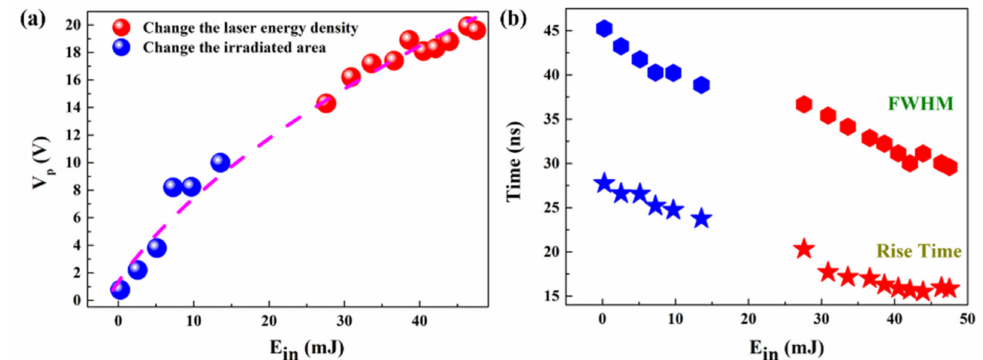
Figure 7. ( a ) V p as a function of the E in of a 248 nm laser. ( b ) Variation of rise time and FWHM with E in of pyrite